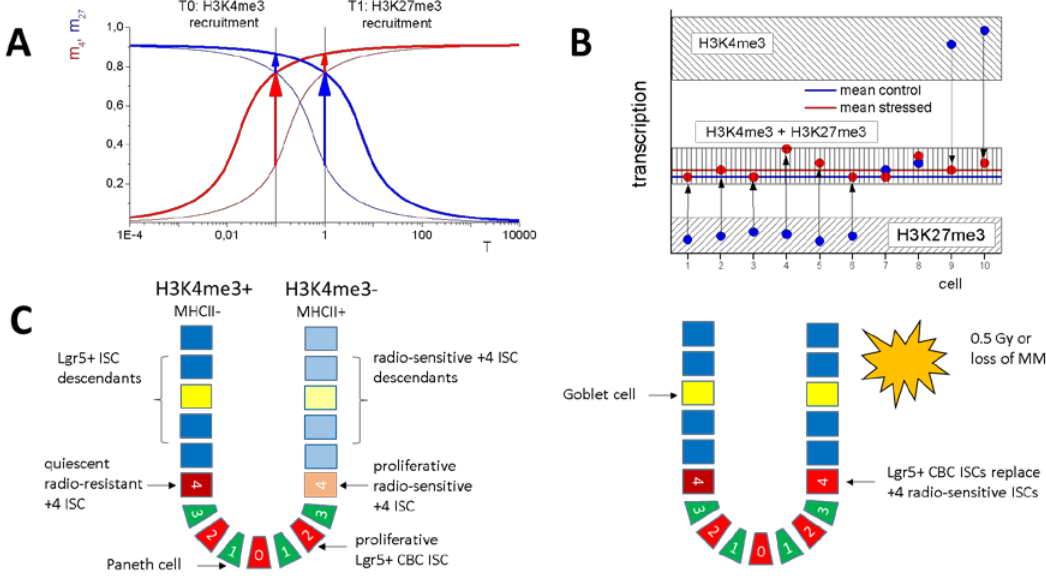
Figure 6. Hypothetic regulation scenario following DNA damage. ( A ) Lower promoter